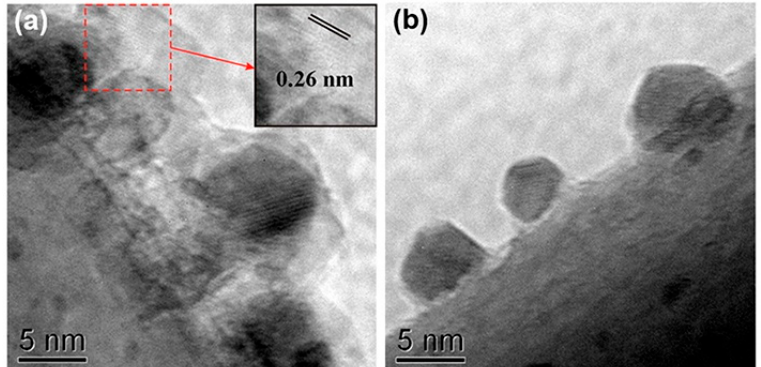
Figure 4. HRTEM images of ( a ) the Au/ZnO-nanorod catalyst pretreated at 300 °C in 10% O 2 /He and ( b ) Au/ZnO-nanorod sample further reduced at 300 °C in H 2 after oxidation pretreatment. Reproduced with permission from [44], copyright: 2012 by the American Chemical Society.